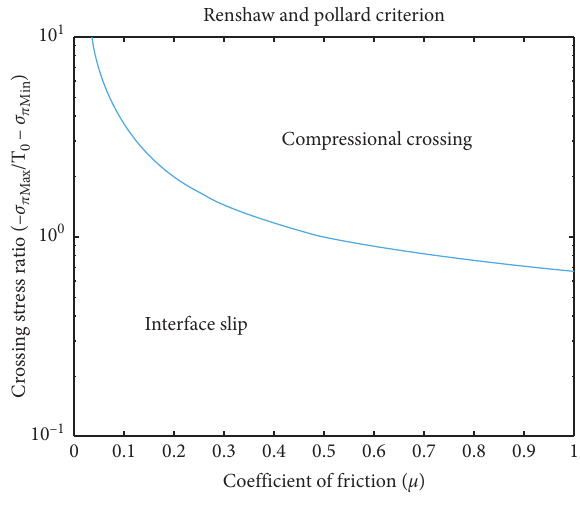
Figure 5: The curve of R&P’s